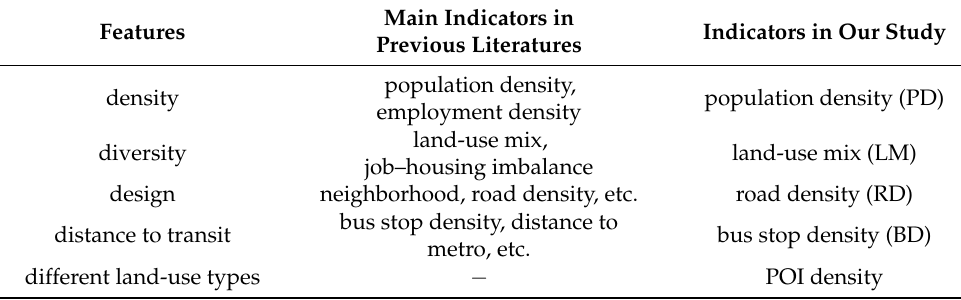
Indicators in Our Study